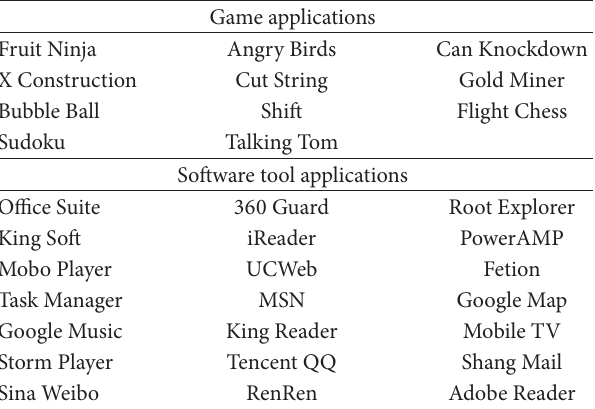
Table 2: Applications for